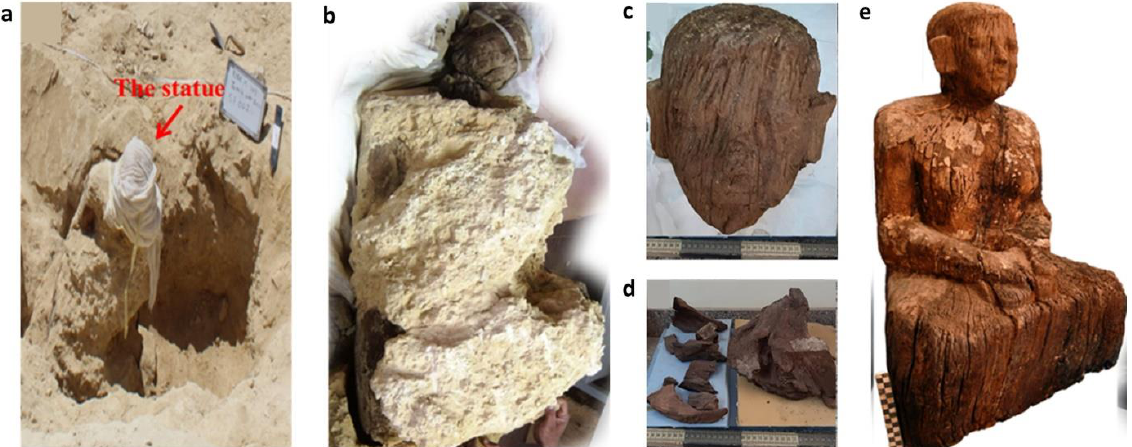
Figure 1. ( a ) The statue at the excavation site at the time of discovery. ( b ) The statue was mostly covered by a thick soil layer. ( c ) The detached head before the restoration. The facial features were not clearly recognisable. ( d ) Fallen wood fragments after soil layer removal. ( e ) The statue after a partial restoration at the Grand Egyptian Museum (GEM) Conservation Lab (Cairo, Egypt).